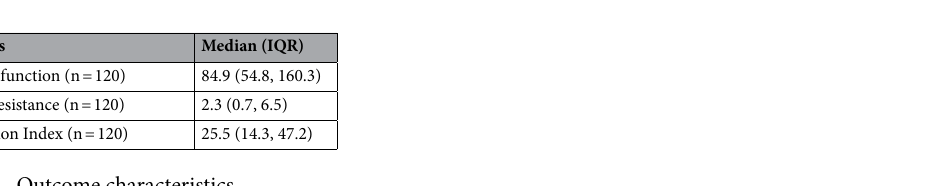
Table 4. Outcome